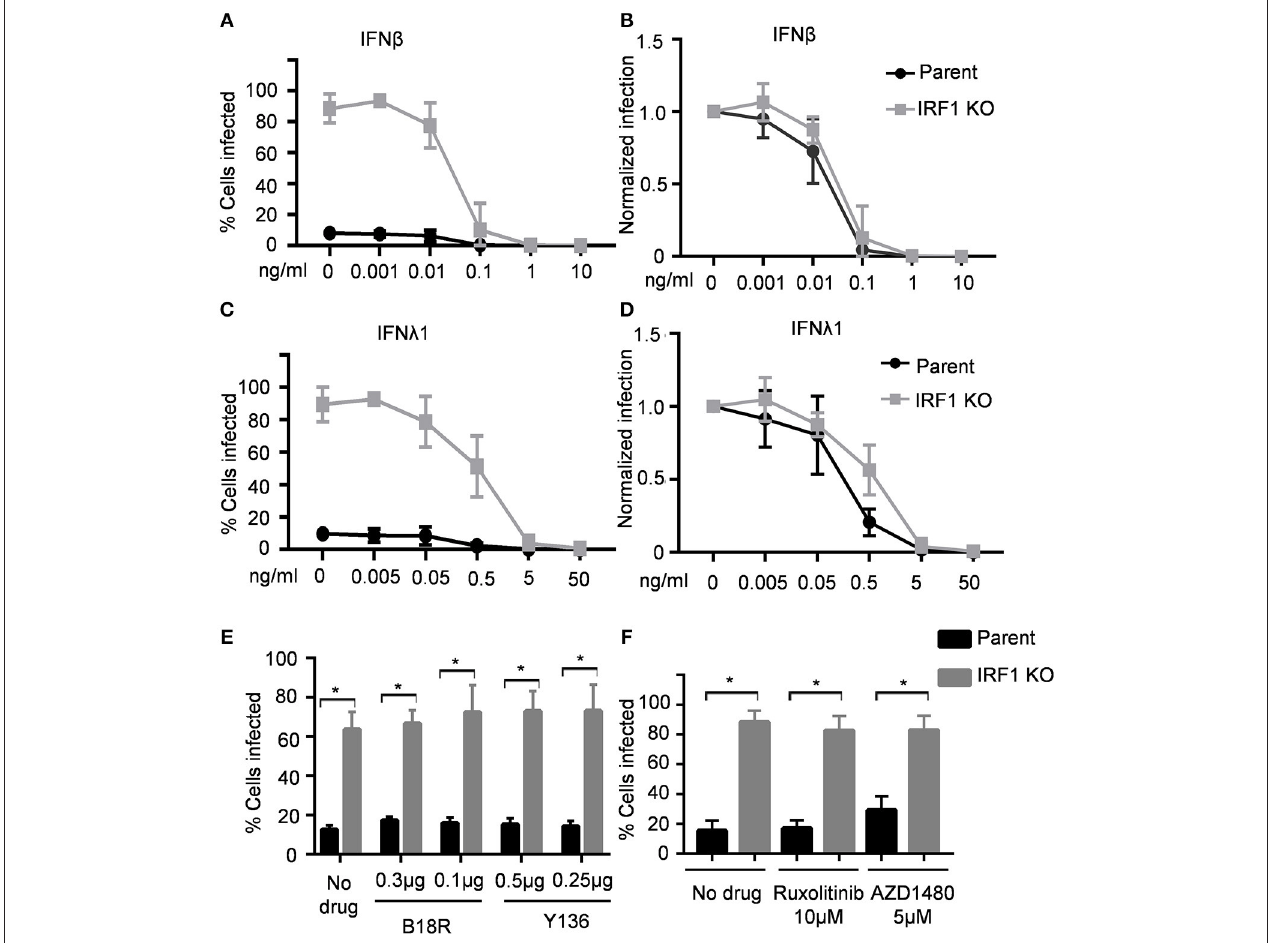
FIGURE 4 | IRF1 is dispensable for IFN-mediated restriction of VSV in BEAS-2B cells. Parent and IRF1 KO cells were pre-treated with IFN β (A,B) or IFN λ 1 (C,D) for 6h, then infected with VSV in the presence of IFN, and harvested at 20 hpi for flow cytometry. Data represent mean ± SD from three independent experiments. Percent cells infected is shown in (A,C) and normalized infection is shown in (B,D) . (E) Parent and IRF1 KO BEAS-2B cells were either treated with vehicle control or with B18R or Y136 proteins 24h before infection. Cells were then infected with VSV at 0.01 MOI in the presence of B18R or Y136 and percent cells infected at 18 hpi was analyzed by flow cytometry. Data represent mean ± SD from three independent experiments. (F) Parent and IRF1 KO BEAS-2B cells were either treated with vehicle control or with JAK inhibitors 24h before infection and then infected with VSV at 0.01 MOI in the presence of the drugs. Percent cells infected at 18h was analyzed by flow cytometry. Data represent mean ± SD from three independent experiments. *Statistically